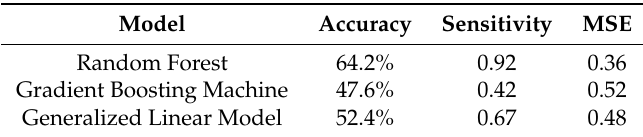
Table A2. Confusion matrix for gradient boosting machine when predicting the reliability of small WWTPs.